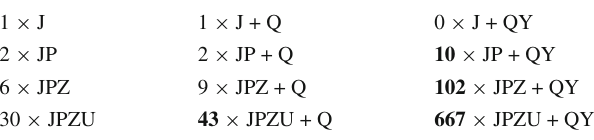
Resonant J + Q, JP + Q, JPZ + Q superalgebras Table 1 Resonant algebras and superalgebras depending on the gener-